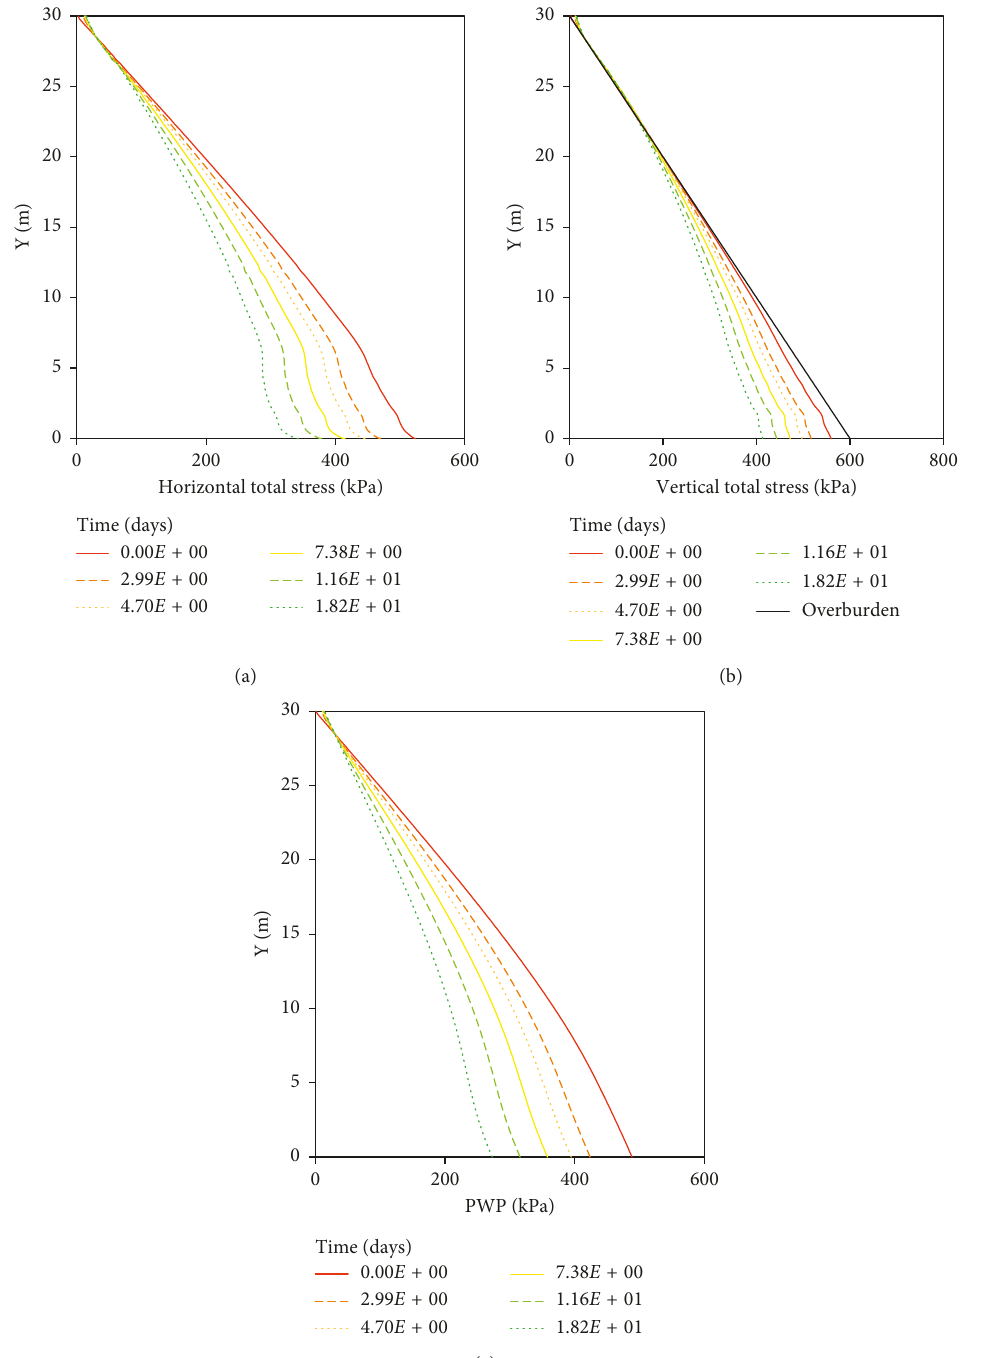
Figure 5: Evolution of the (a) horizontal ( σ h ) and (b) vertical ( σ v ) total stresses and (c) the PWP ( u w ), along the vertical profile VP after the addition of the 150 th (last) layer of backfill in the stope for the reference case (see the details in Table 1, Case